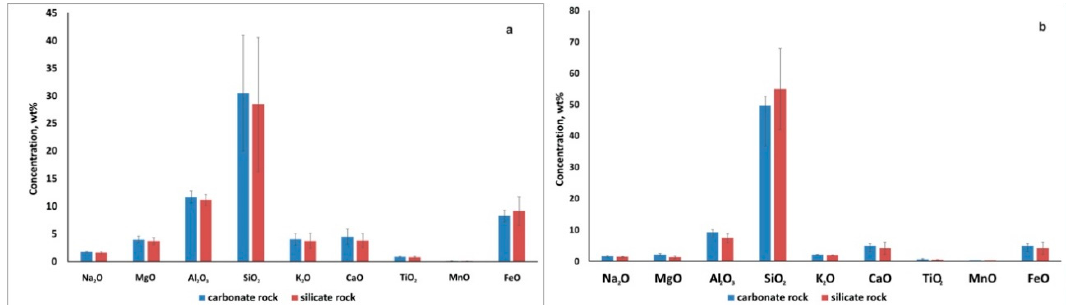
Figure 10. Comparison of average concentrations (wt%) of the main impurity elements in biodeposits on carbonate and silicate rocks: ( a )—in mosses (III type of biodeposits); ( b )—primary soil under them (IV type of biodeposits) .